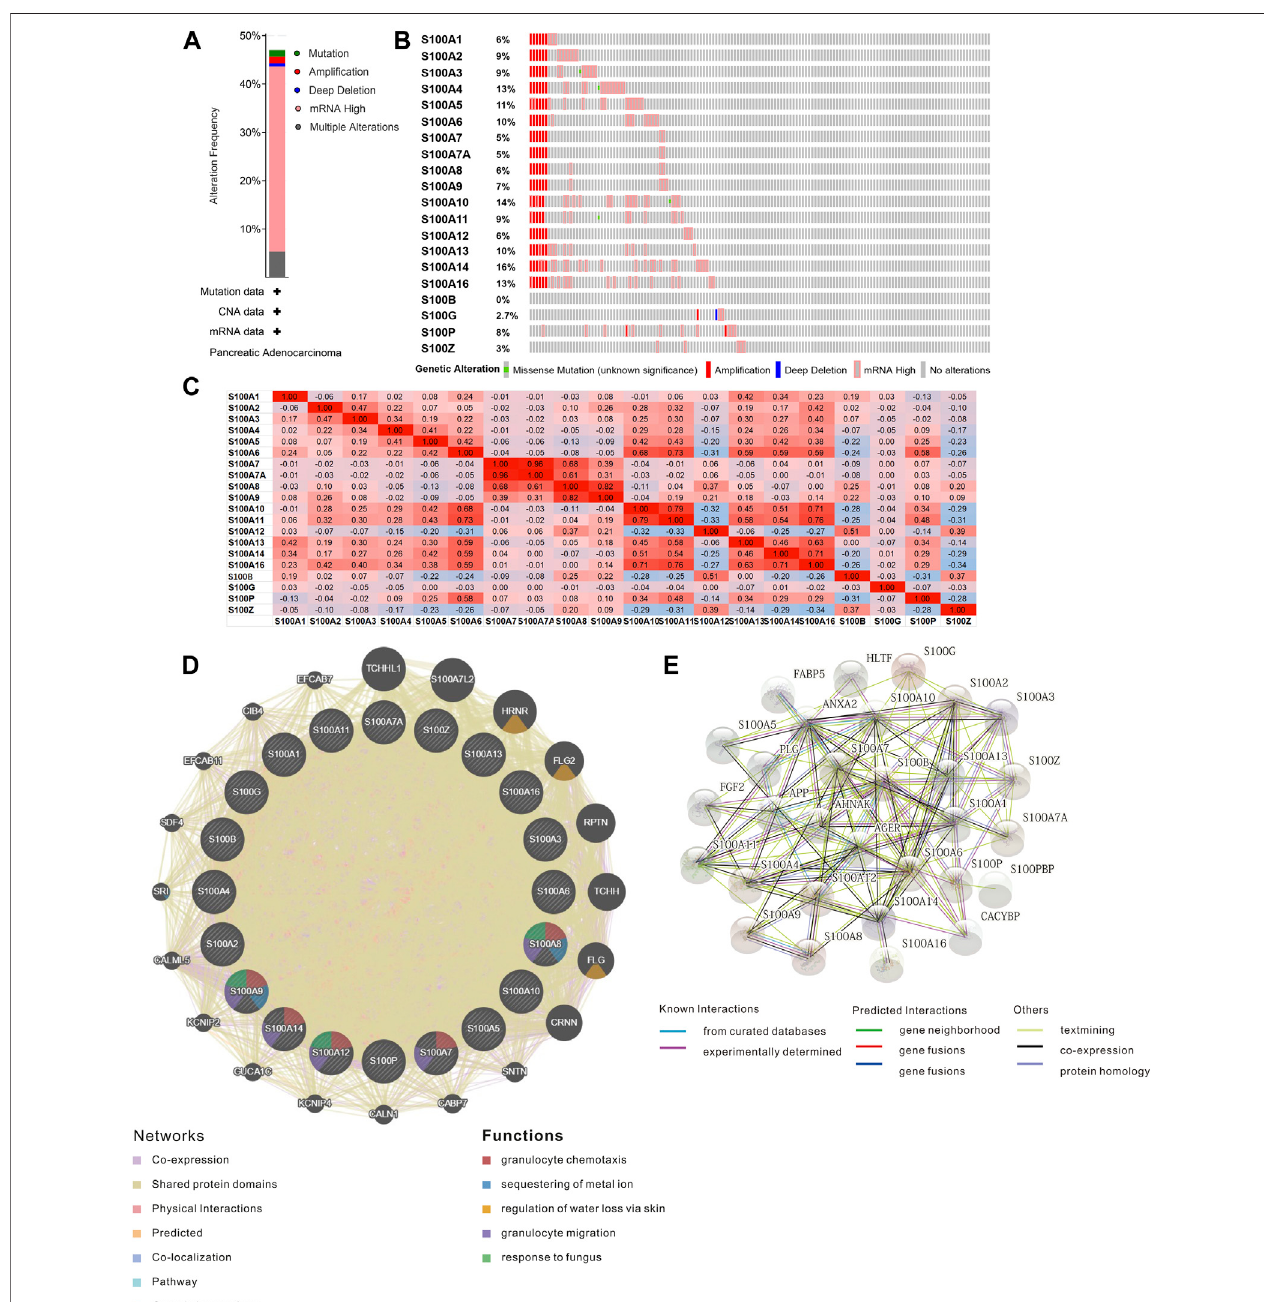
FIGURE 7 | Genetic mutation and interaction networks analysis of the S100s members in PAAD (cBioPortal, GeneMINIA, and STRING). (A) Summary of mutation frequency in S100 factors in PAAD (n (cid:1) 149), (B) Genetic alteration ofeach S100s in PAAD (n (cid:1) 149), (C) Correlation among different S100s factors in PAAD by Pearson ’ s correlationcoef fi cientsbasedoncBioportaldatabases(positivecorrelationisred,negativecorrelationisblue,n (cid:1) 149), (D) GeneinteractionnetworksamongS100sinthe GeneMANIA database. (E) Protein-protein interaction network of the S100s members in PAAD.